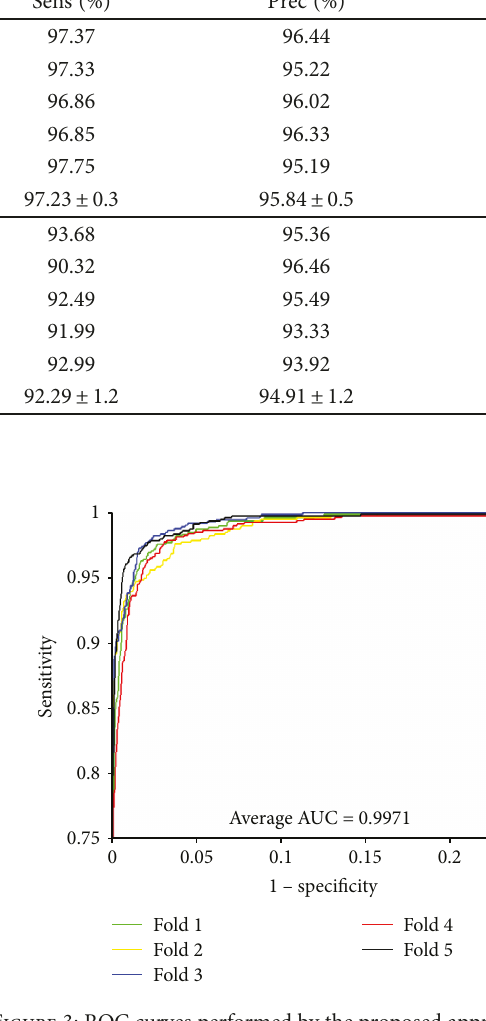
Figure 2: ROC curves performed by the proposed approach on the human dataset.